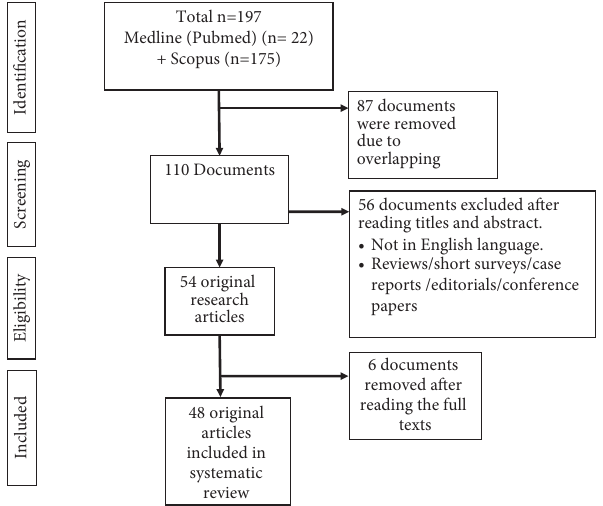
Figure 2: PRISMA flow for literature